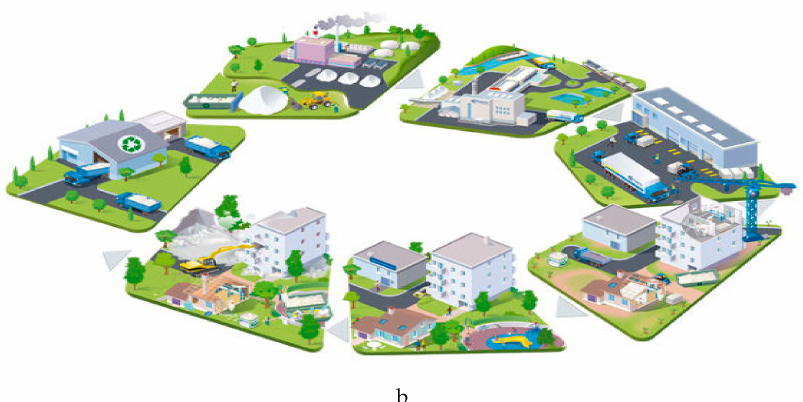
Figure 1. ( a ) Life cycle assessment (LCA) stage according to ISO 14044 [21]. ( b ) 3D modeling of some habitats in the studied site.